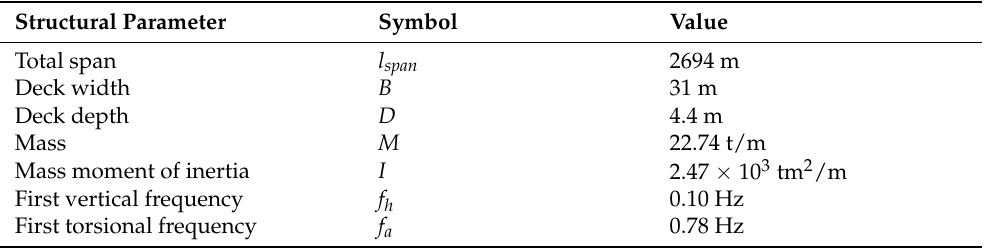
Figure 5. General arrangement of the Great Belt Bridge: deck cross-section (top) and bridge elevation (bottom) [37,38]. Table 1. Structural properties of the Great Belt Bridge [37] .